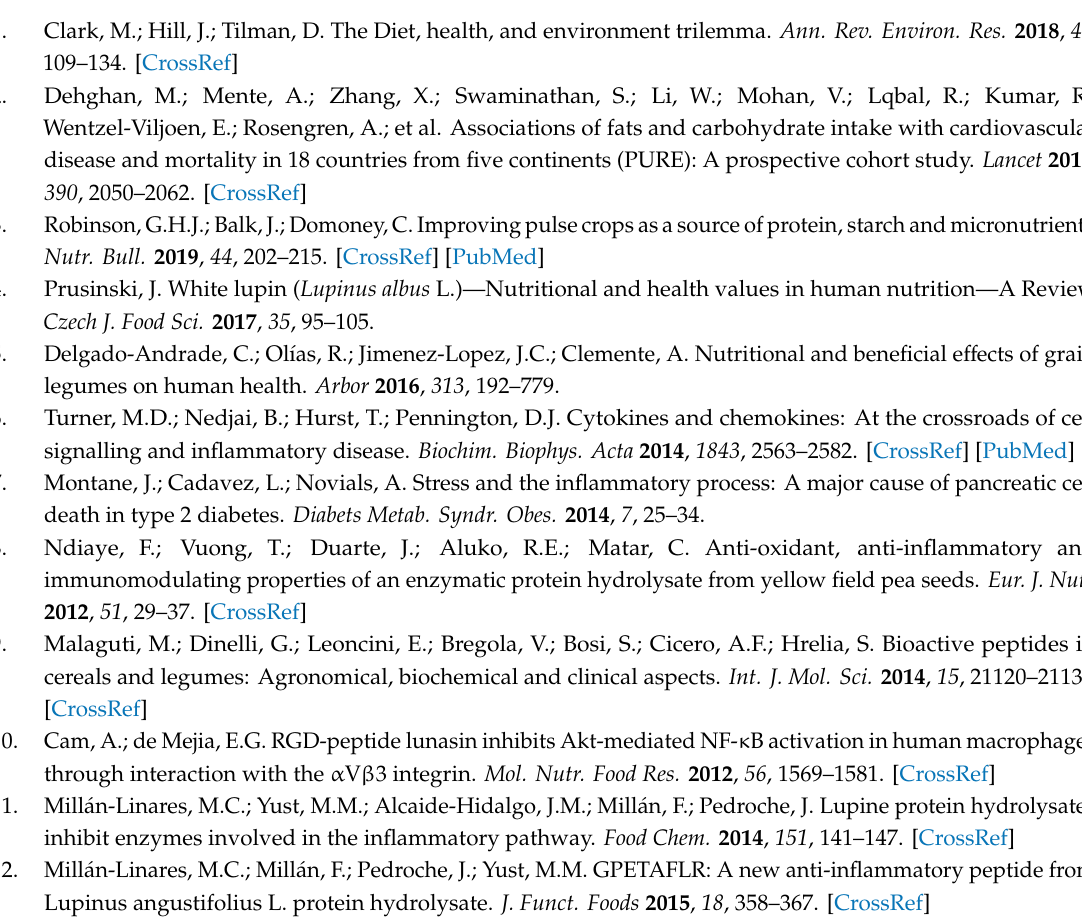
Table S3: Cell viability (%) on insulin resistance IR-C cell model; Table S4: Cell viability (%) and dose e ff ects of purified NLL γ -conglutin protein on insulin resistance cell (IR-C) model; Table S5: Fold-change in protein levels of pro-inflammatory cytokines and iNOS; Table S6: Fold-change in protein levels of pro-inflammatory cytokines and